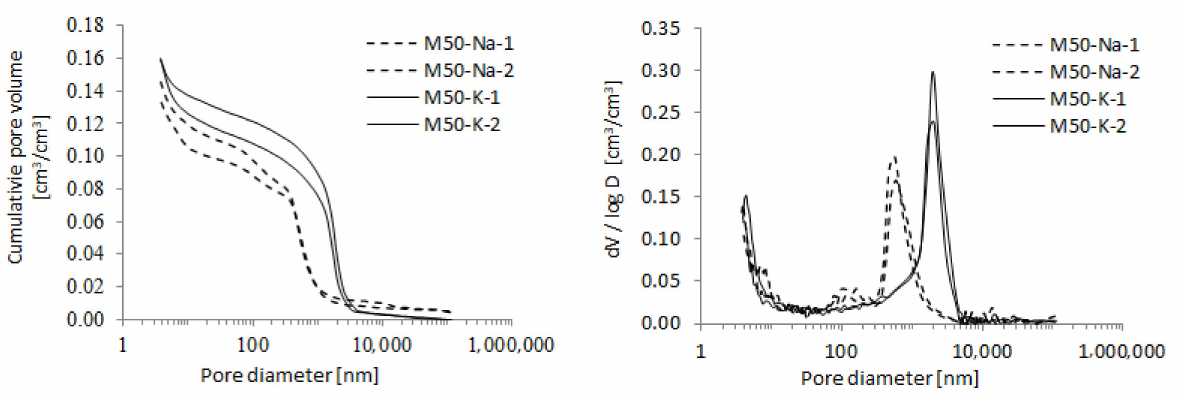
Figure 4. The cumulative pore volume and pore size distribution for binder containing 50% FA and 50% of GGBFS.